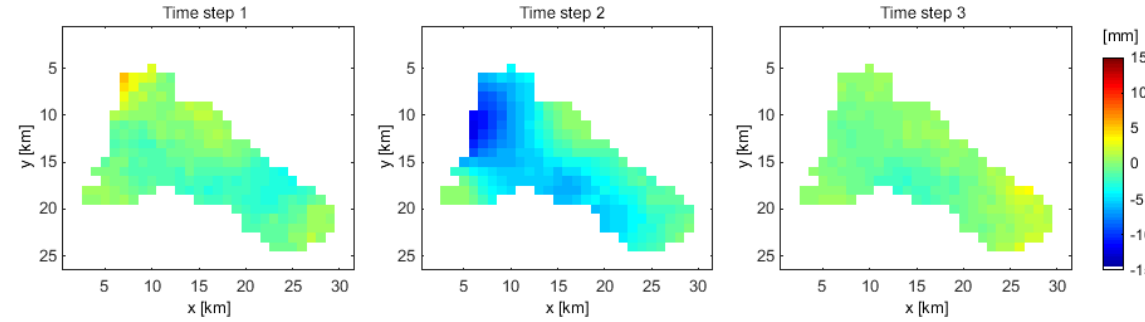
Figure 13. Differential maps of spatio-temporal rainfall patterns for three consecutive time steps (simulation –